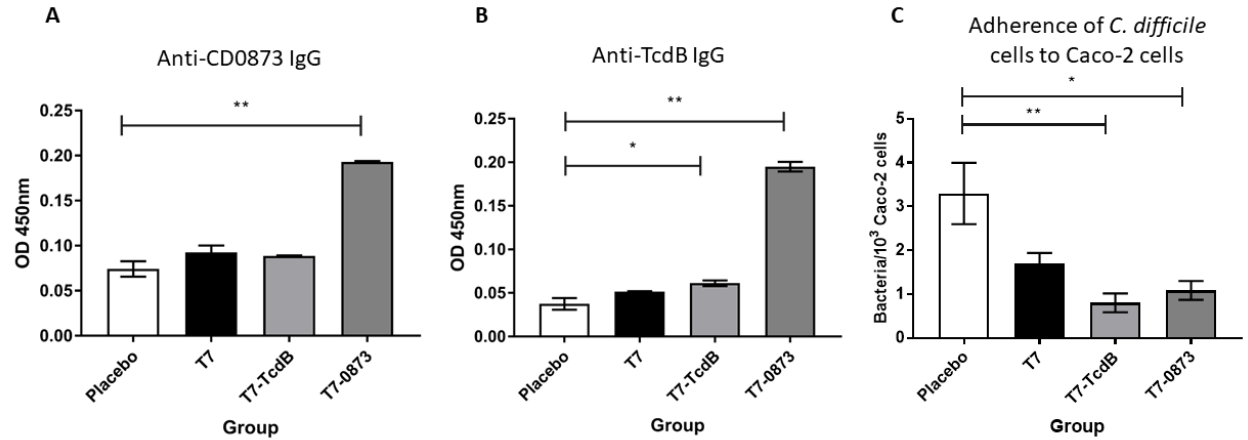
Figure 5. Systemic immune responses in hamsters 2 weeks after oral immunisations with 10 6 spores of strains T7, T7-TcdB and T7-0873: 3 doses, 2 weeks apart. Sera were diluted 1:10 and quantified for antigen-specific IgG by indirect ELISA: CD0873 ( A ) and TcdB-RBD ( B ). Goat anti-hamster IgG highly cross-adsorbed Biotin antibody (1:20,000) and Streptavidin-HRP (1:200) were used for detection. ( C ) The effect of sera diluted 1:5 in reducing the binding of C. difficile strain 630 to Caco-2 cells. Error bars represent the standard deviation (SD). The data were analysed by nonparametric ANOVA (Kruskal–Wallis) with Dunn’s uncorrected comparison. Statistical difference p values: * p < 0.05, ** p < 0.01.